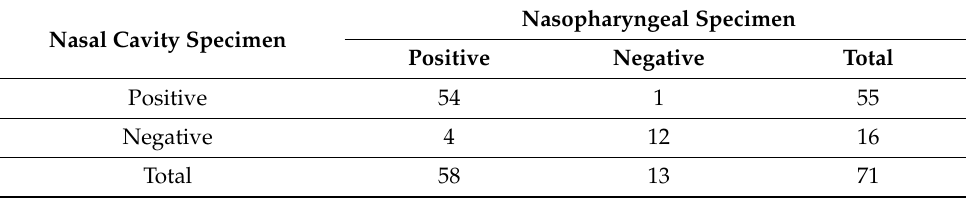
Table 2. Agreement of STANDARD Q COVID-19 Ag test between the nasal cavity and nasopharyn- geal specimens.